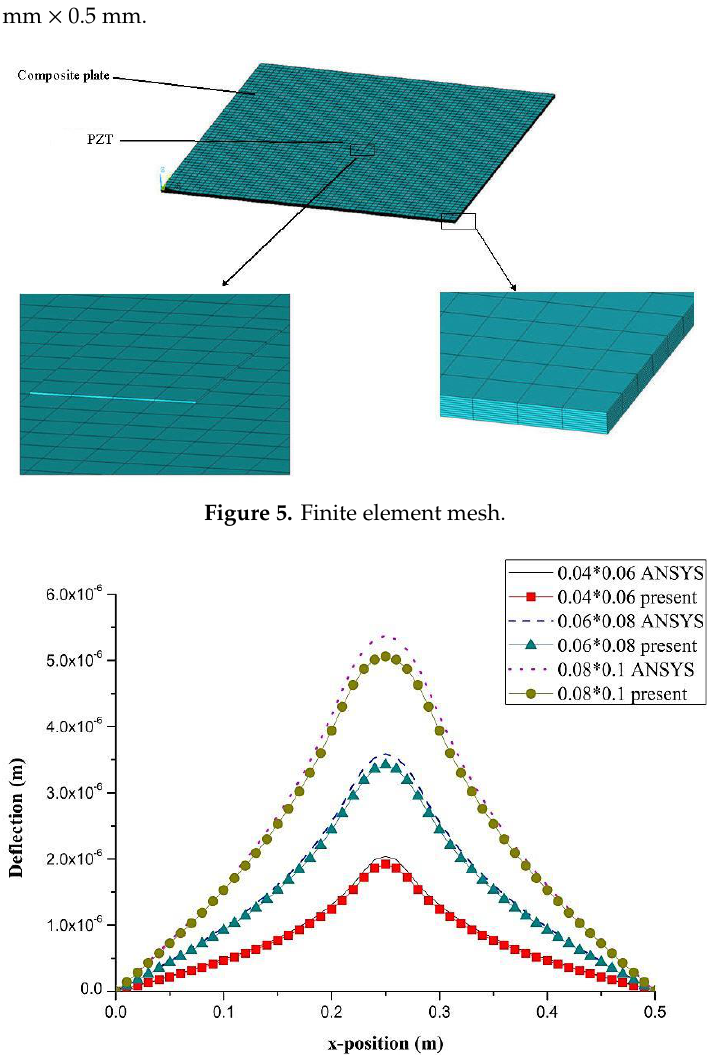
Figure 6. Deflection along the horizontal line (y = 0.25 m) of the composite laminate plate induced by PZT actuator with three different sizes.